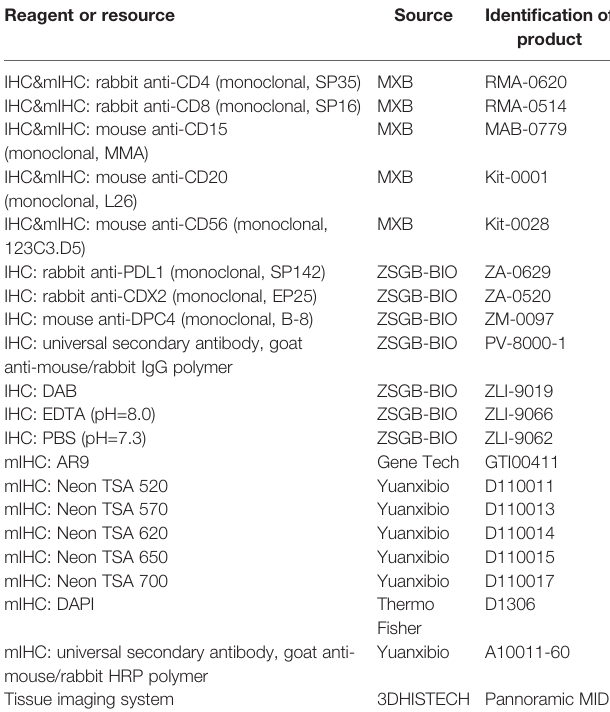
TABLE 1 | Main reagents and